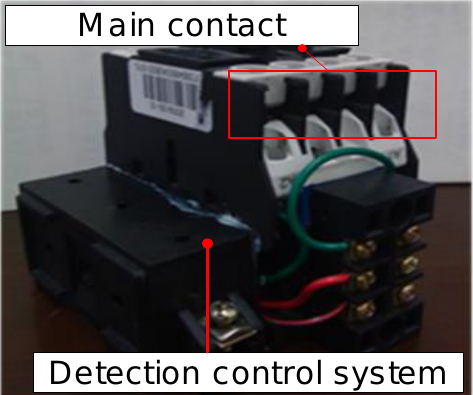
Figure 14. DC leakage circuit breaker prototype.